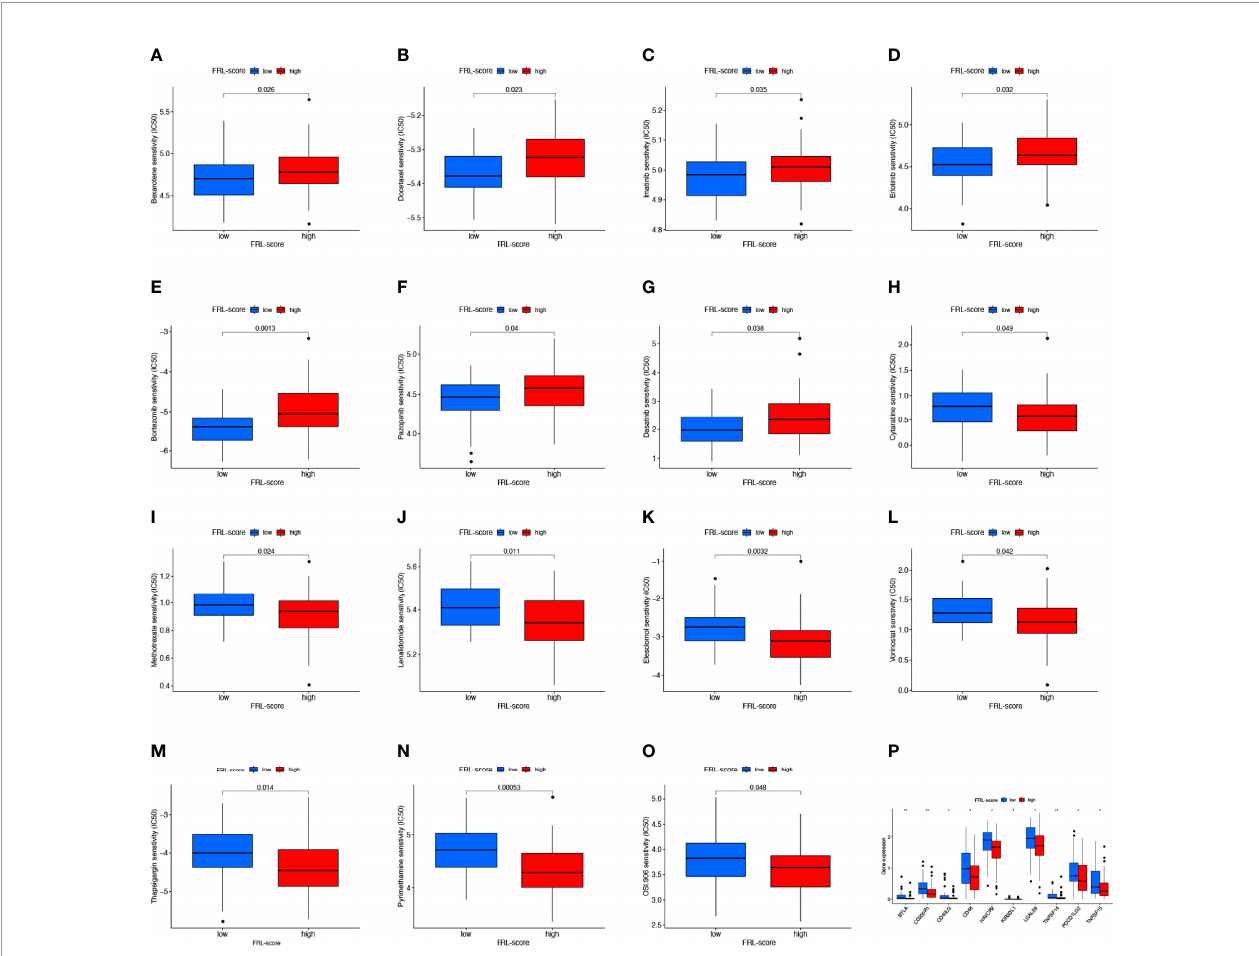
FIGURE 10 | Drug sensitivity analysis and immune checkpoint molecules expression analysis. (A – O) Comparison of drug sensitivity between different FRL-score subgroups, including bexarotene (A) , docetaxel (B) , imatinib (C) , erlotinib (D) , bortezomib (E) , pazopanib (F) , dasatinib (G) , cytarabine (H) , methotrexate (I) , lenalidomide (J) , elesclomol (K) , vorinostat (L) , thapsigargin (M) , pyrimethamine (N) , and OSI-906 (O) . (P) Differential expression of immune checkpoint genes between different FRL-score